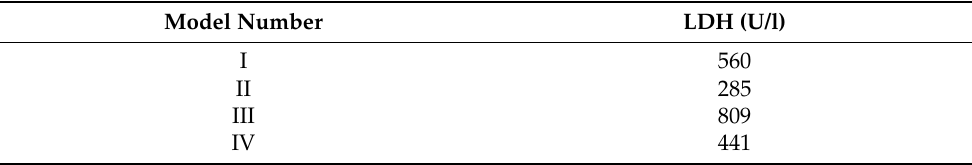
Table 3. LDH levels in subjects with respective